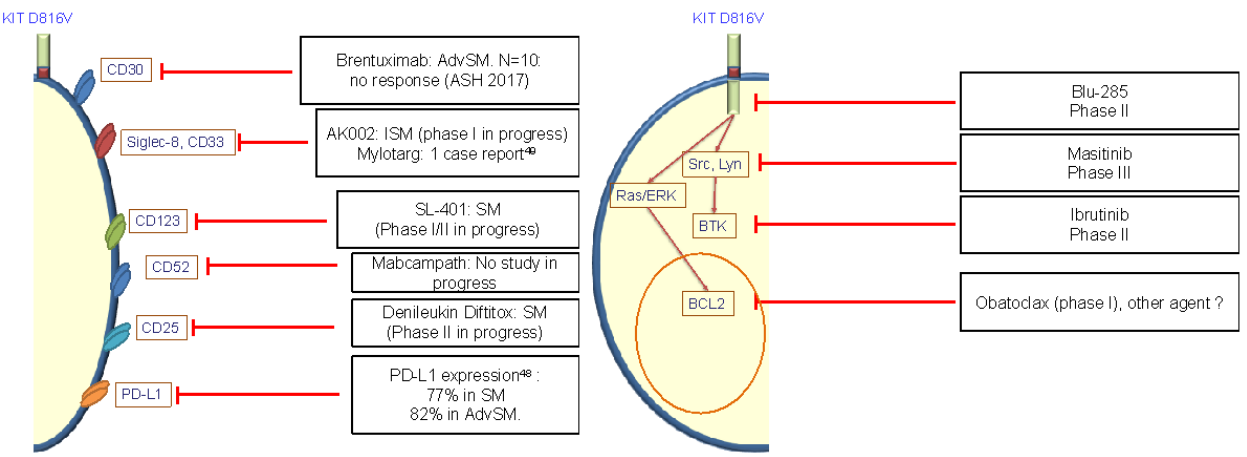
Figure 5. Therapeutic perspectives for mastocytosis 48,49 . AdvSM, advanced systemic mastocytosis; ISM, indolent systemic mastocytosis; SM, systemic mastocytosis. Based on